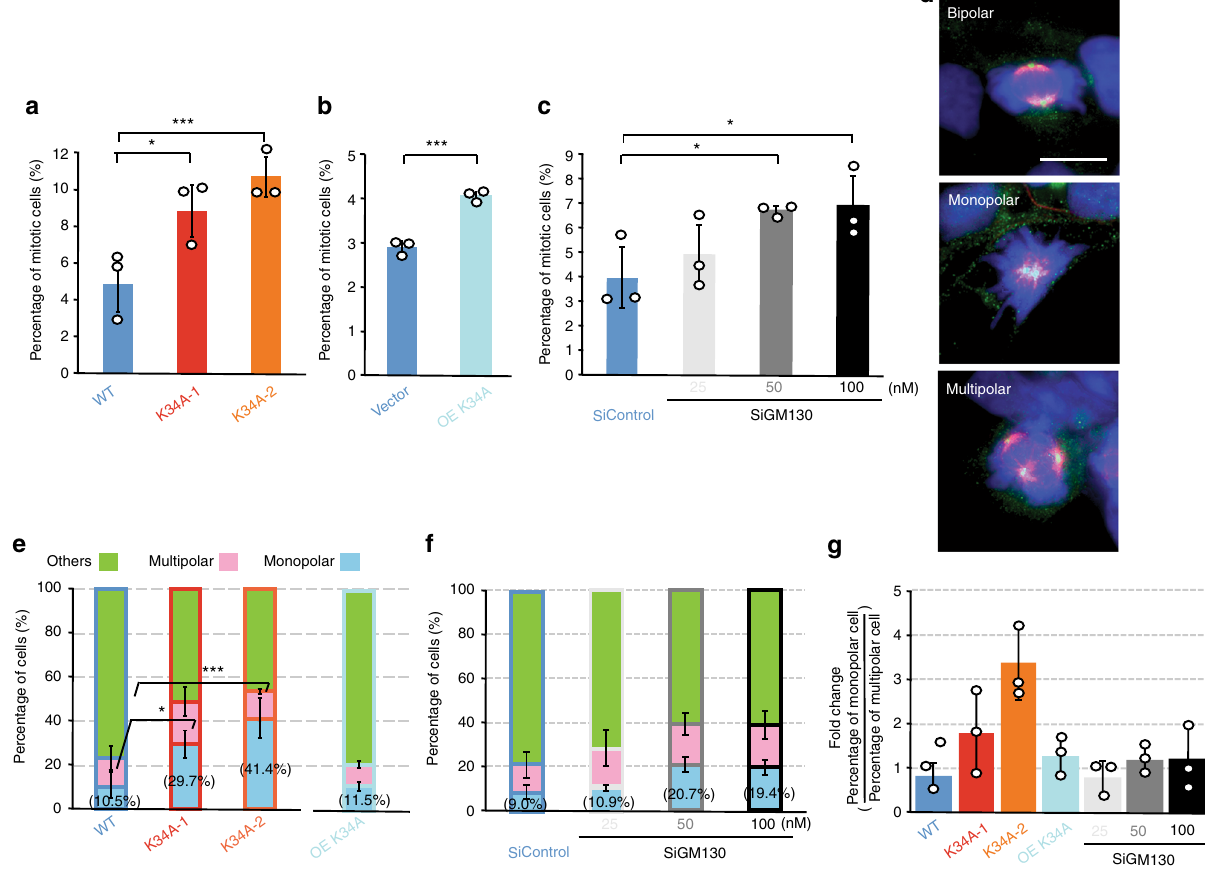
Fig. 7 Perturbation of Golgi disassembly leads to monopolar spindle formation. a – c The indicated cell lines [K34A mutant cell lines ( a ), overexpression GM130 K34A mutant cell lines ( b ), and siRNA-mediated GM130 depletion cell lines ( c )] were grown, fi xed, and stained with α -tubulin antibody and DAPI. The percentages of mitotic cells in total cells of the control/WT (blue), mutant (red and orange), GM130 K34A mutant overexpressing (light blue), and GM130 siRNA treated (gray) cell lines are plotted. One-tailed Student ’ s t- test; *** p < 0.005, * p < 0.05. Overexpression of the GM130 K34A mutant is indicated as OE K34A. Concentrations of siRNA oligonucleotides are indicated. d Representative merged fl uorescent images of K34A mutant cells containing bipolar spindles (top), monopolar spindles (middle), and multiple polar spindles (bottom) at metaphase. Cells were immuno-stained with γ - tubulin antibody, α -tubulin antibody, and DAPI. Scale bar: 10 μ m. e , f The percentages of cells containing monopolar and multiple spindles in total mitotic cells of the indicated cell lines are plotted. Percentages of monopolar spindle cells, multiple spindle cells and other mitotic cells are shown in light blue, pink, and light green bars, respectively. One-tailed Student ’ s t- test; *** p < 0.005, * p < 0.05. g Ratios of monopolar spindle cells and multiple spindle cells of the indicated cell lines are plotted. Mean± standard deviation of the percentages of the cells were calculated from n = 3 independent experiments. WT ( N = 1316 cells); K34A-1 ( N = 963 cells); K34A-2 ( N = 1064 cells); Vector ( N = 4002 cells); OE K34A ( N = 2539 cells); SiControl ( N = 1488 cells); SiGM130- 25 ( N = 1193 cells); SiGM130-50 ( N = 1331 cells); SiGM130-100 ( N = 1021